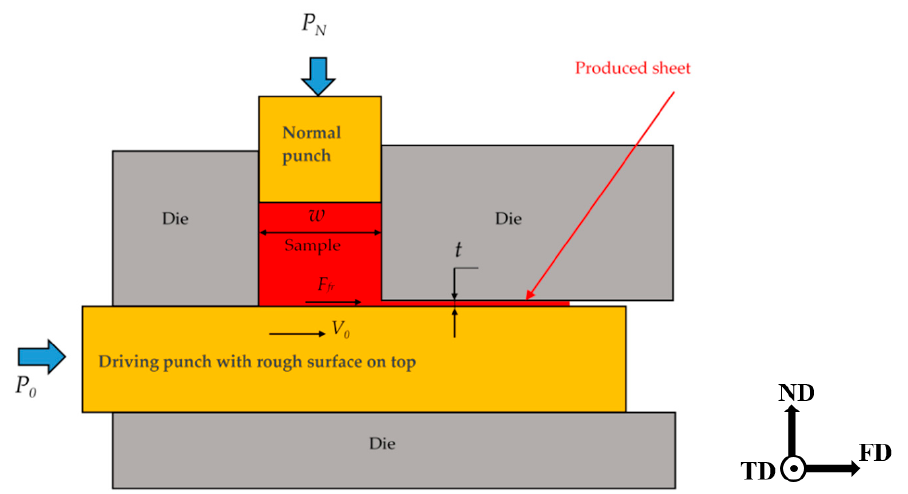
Figure 1. Schematic of the FALEP process.